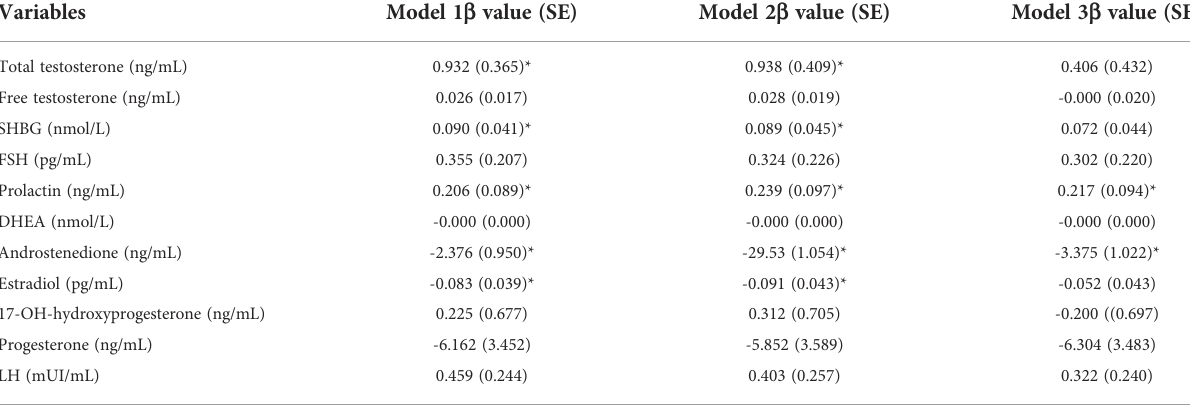
TABLE 3 Linear regression models assessing the association between 25-hydroxyvitamin D with sex-related hormones in men with obesity. Variables